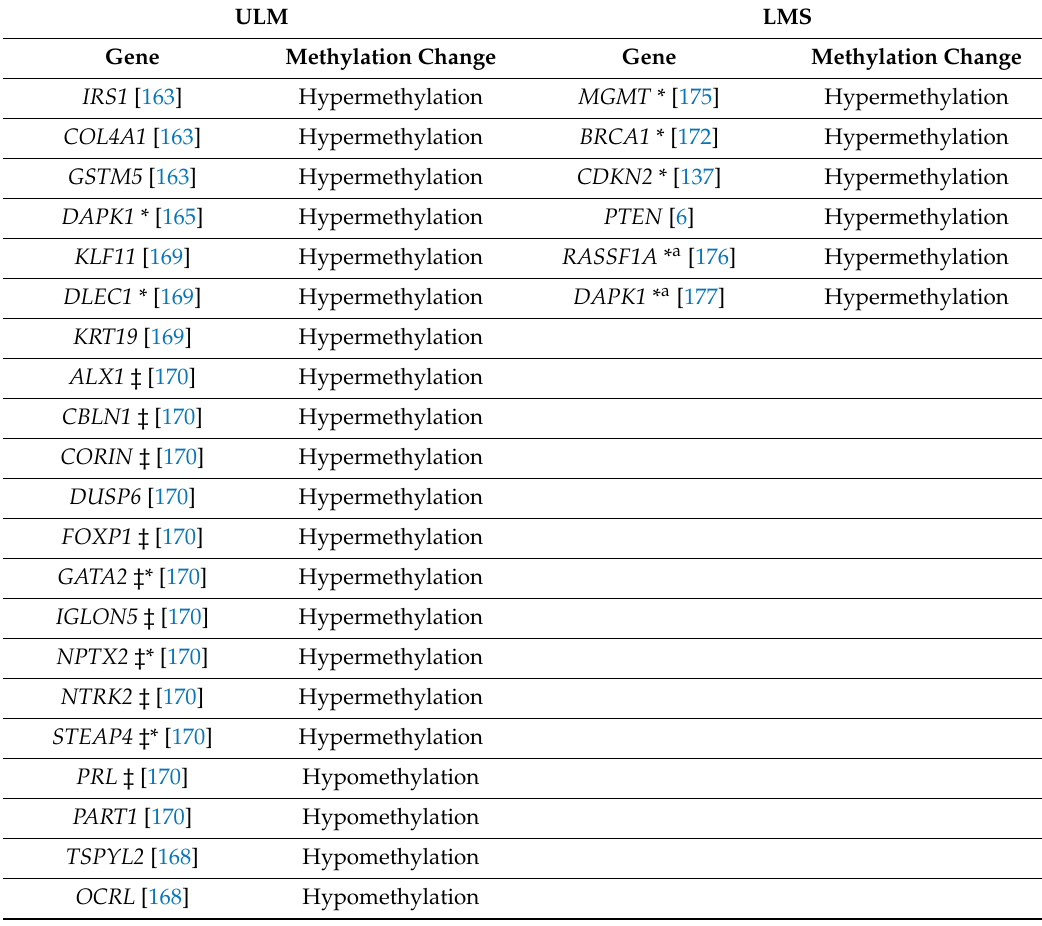
Table 3. Abnormally methylated genes in ULM and